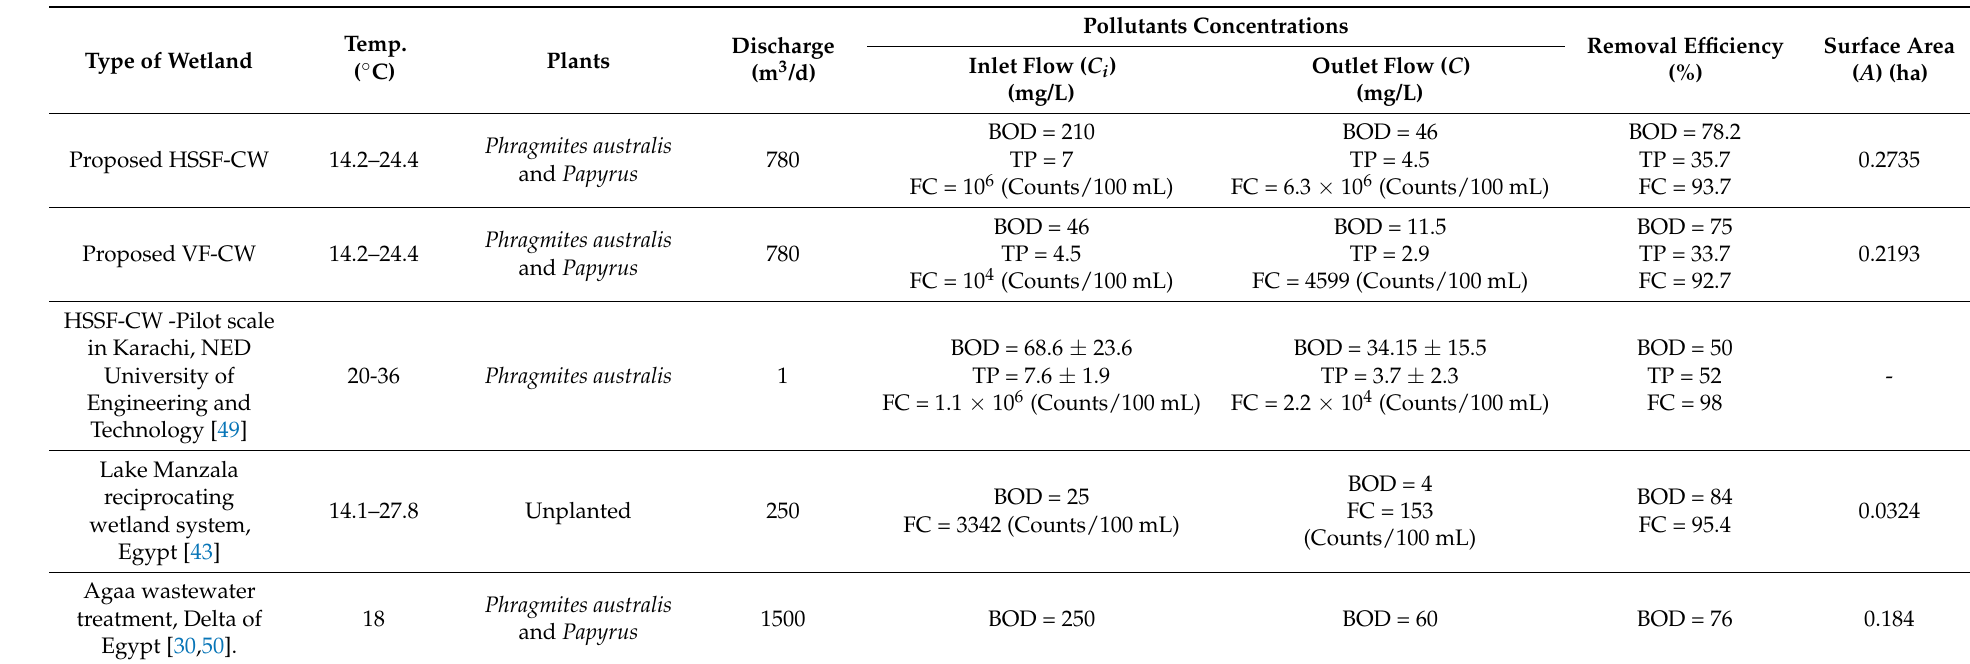
Table 9. Comparison of the proposed HSSF-CW predicted removal efficiencies with monitored case